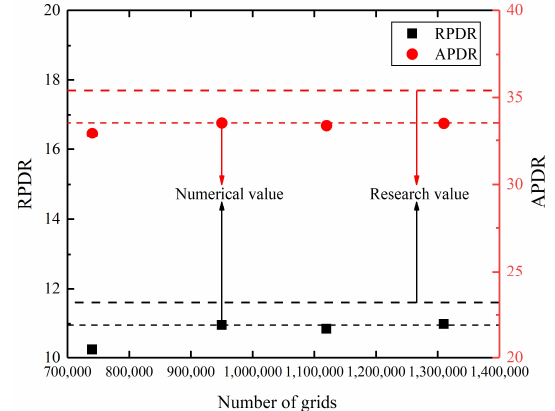
Figure 5. The verification of mesh independence.